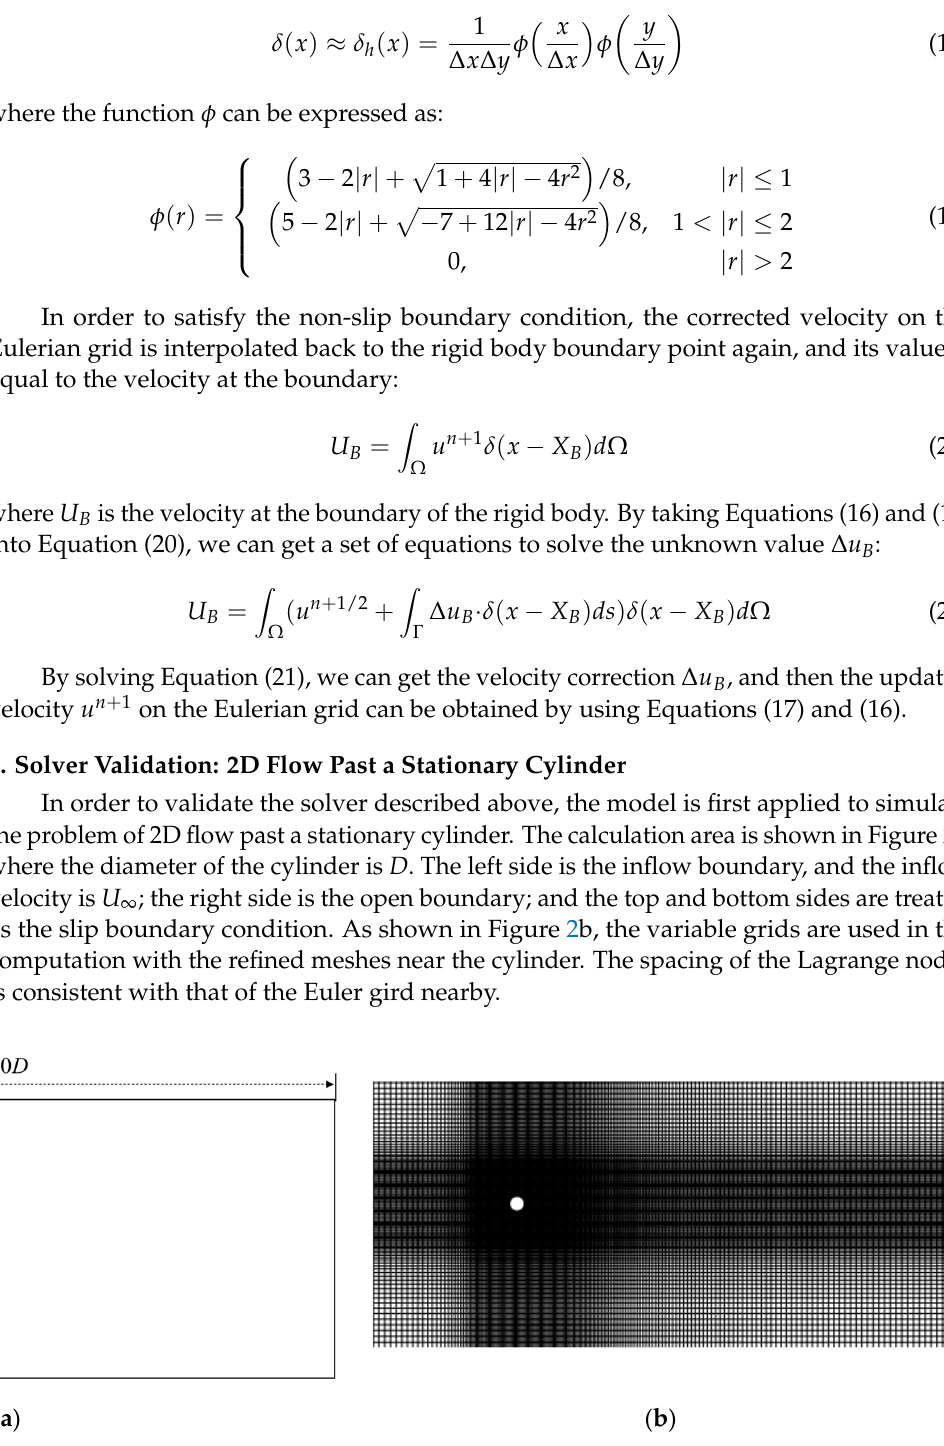
In the present simulations, three different sizes of mesh are chosen. The minimum gird is ∆ x = ∆ y = 0.04 D , ∆ x = ∆ y = 0.02 D and ∆ x = ∆ y = 0.01 D , respectively. The drag and